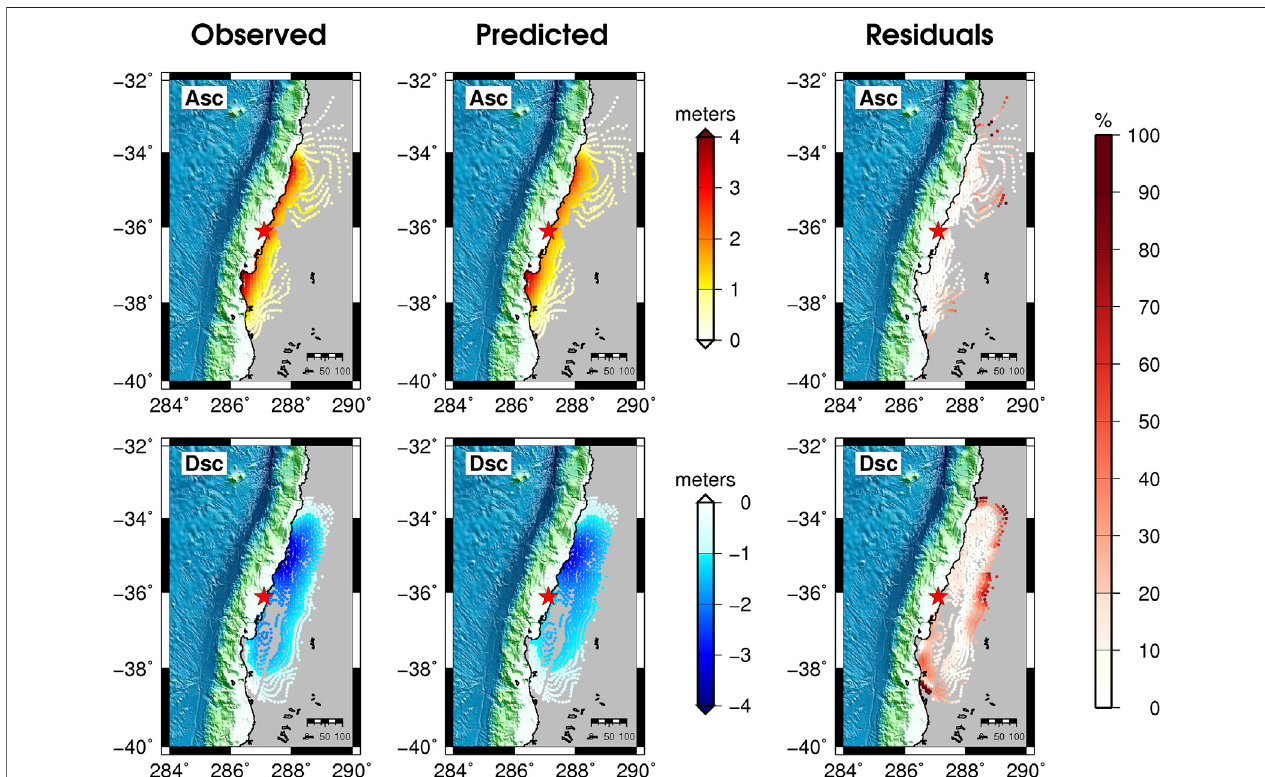
FIGURE13| Comparisonbetweenobserved,predicted,andpercentageresidualsofascending( upperpanels )anddescending( bottompanels )InSARdatafor the slip distribution shown in Figure 11 .